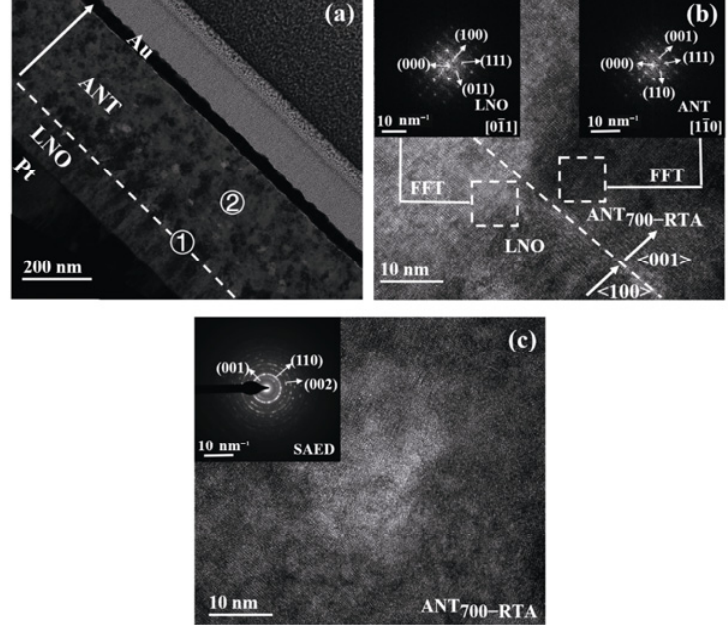
Fig. 6 (a) Cross-sectional low-magnification TEM image of ANT 700-RTA /LaNiO 3 /Pt/Ti/Si thin film heterostructure. (b) Representative high-resolution TEM (HRTEM) image taken at ANT 700-RTA /LaNiO 3 film interface (circled and marked as the area  in (a)); the two corner insets are fast Fourier transformed-selected area electron diffraction (FFT-SAED) patterns of LaNiO 3 and ANT layers. (c) Representative HRTEM image of ANT layer (circled and marked as the area  in (a)); the top-left inset is the SAED pattern of ANT layer as a